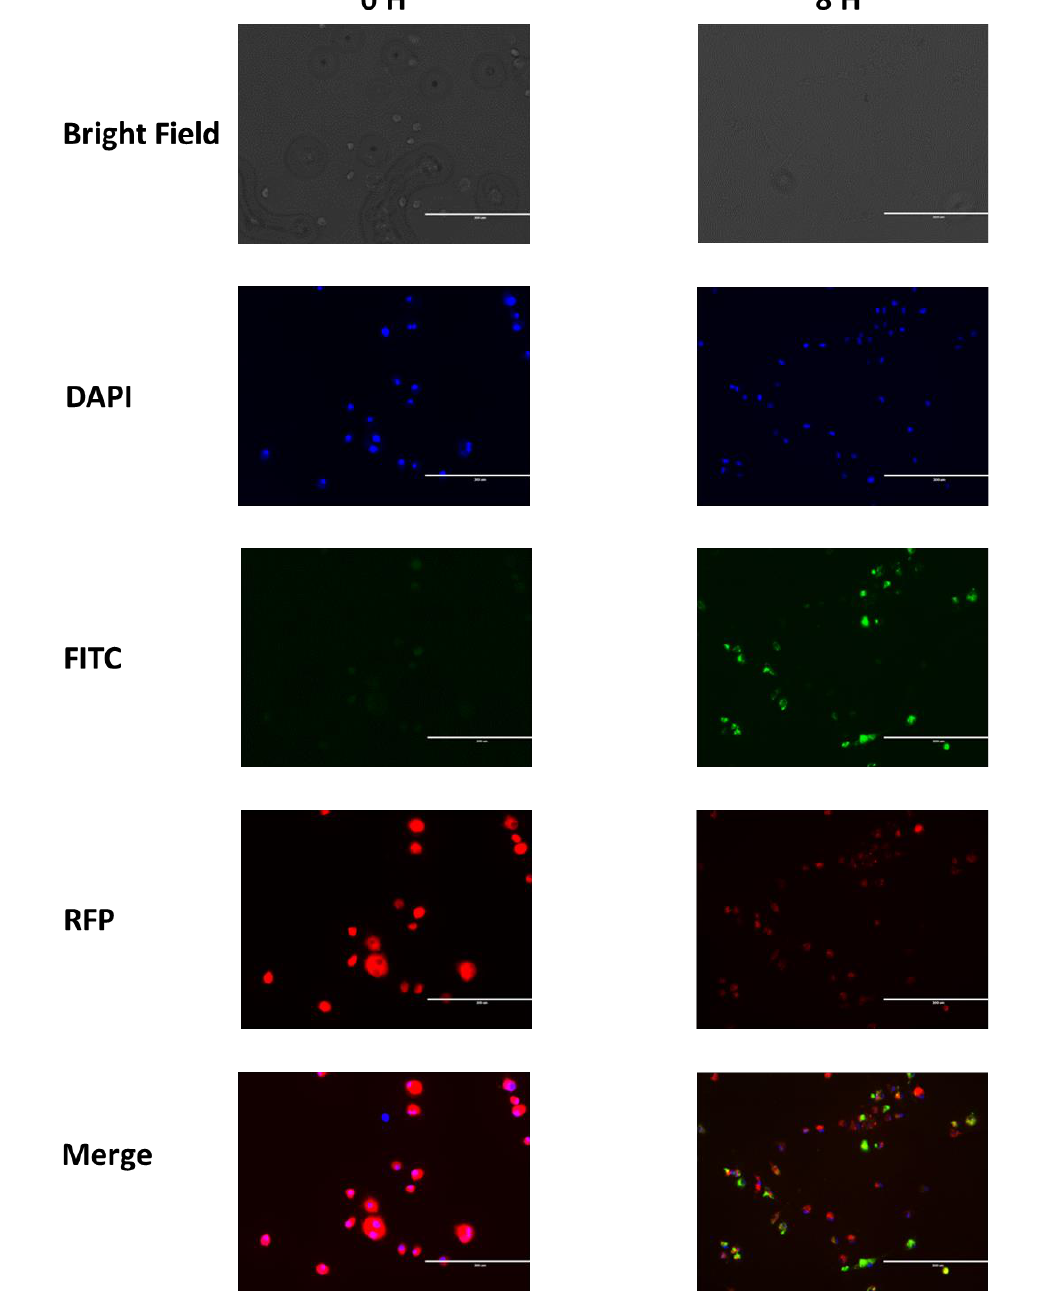
Figure 4. Peritoneal macrophage phagocytosis of FITC chitosan nanoparticles at 0 and 8 h showing the nanoparticles inside of cell lysosomes at 8 h. The DAPI filter shows the nuclei, the FITC filter demonstrates the nanoparticles, and the RFP filter indicates the lysosomes.